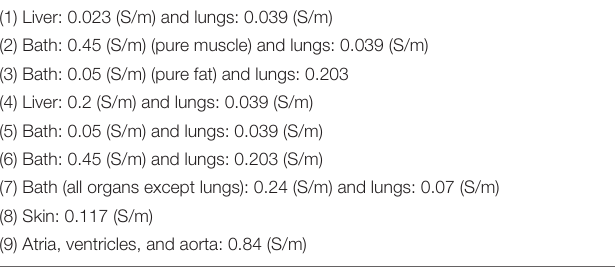
TABLE 2 | Variations in body compositions.